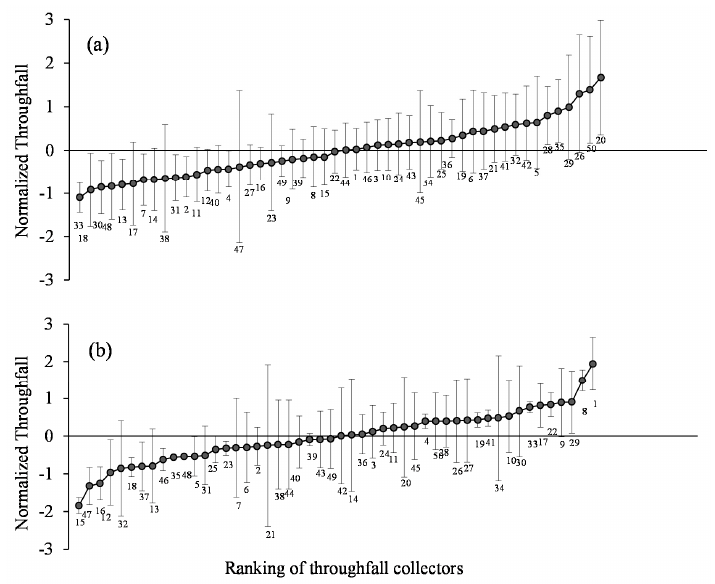
Figure 7. Time stability plots of cumulative throughfall ( TF ) normalized to zero mean and unit variance for the ( a ) leafed and ( b ) leafless periods. The TF gauges are plotted along the horizontal axis and ranked by their means. Error bars represent ± 1 standard deviation. The numbers underneath each bar are the gauge